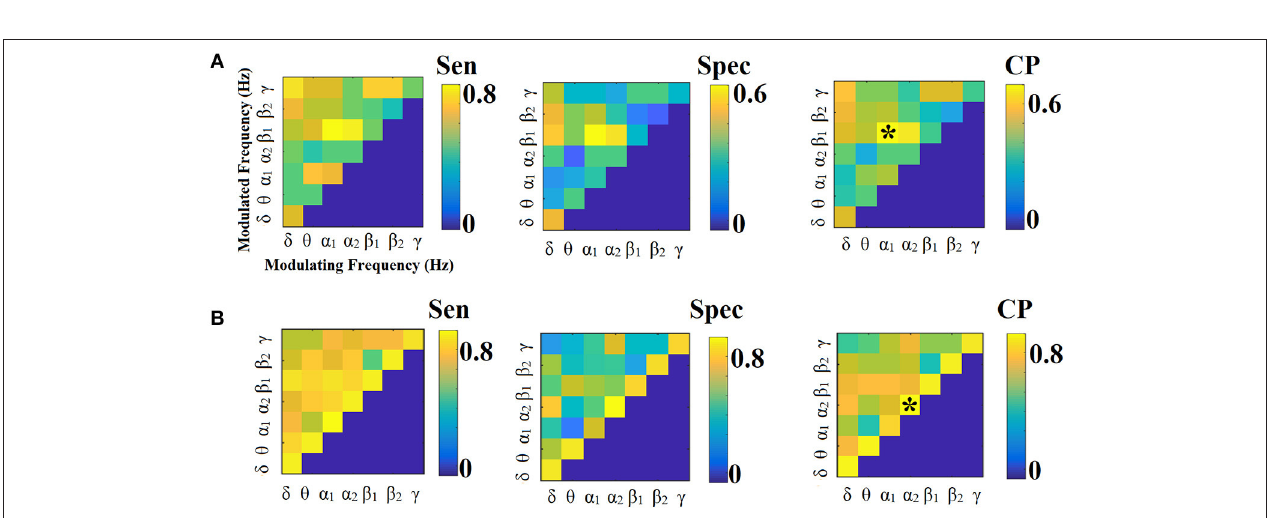
FIGURE 7 | Sensitivity, specificity and classification performance of iPLV using centroid ROI representation and edge-weights approach of each SL-FCG. (A) Sensitivity, specificity and classification performance for the LOOCV. (B) Sensitivity, specificity and classification performance for the 5-fold CV. * denotes the best CP for each CV scheme. Sen, sensitivity; Spec, specificity; CP, classification